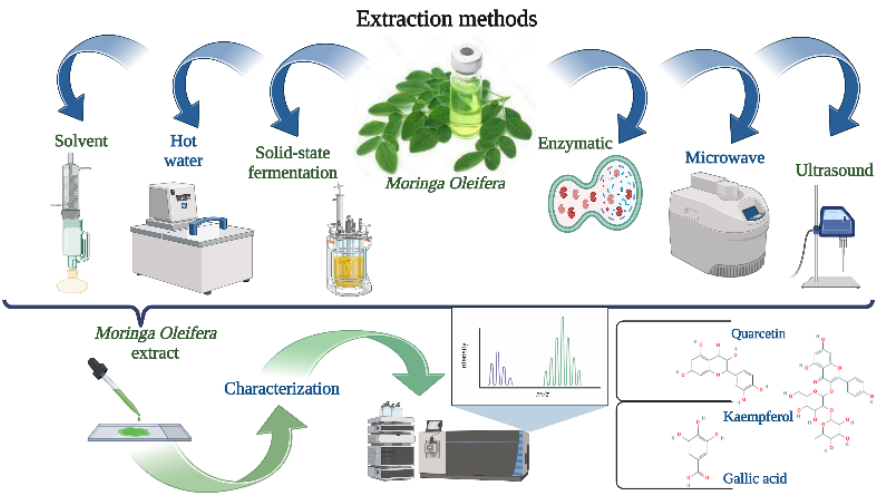
Figure 2. Extraction techniques used before encapsulation of the bioactive compounds from M. oleifera (created with BioRender.com).